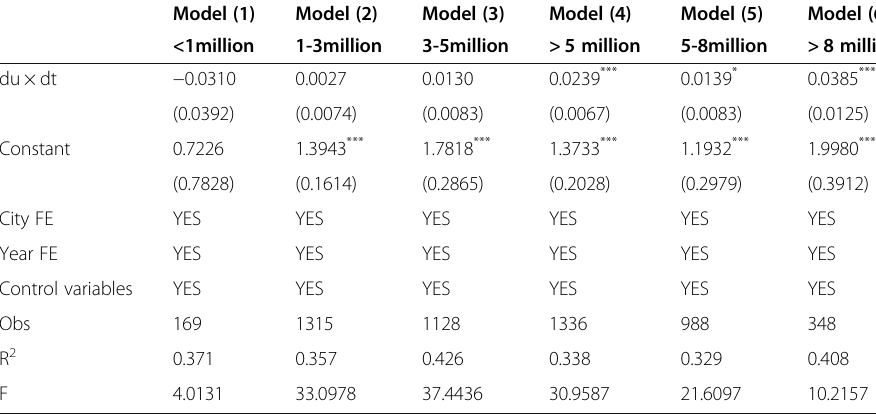
Table 7 Regression results at different city sizes Model (1)